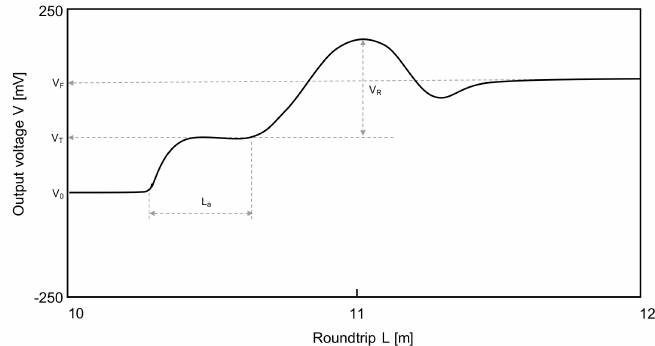
Figure 2. An example of the TDR waveform. V 0 , V T , and V F mean initial voltage, first reflected voltage, and converged voltage, respectively. V R denotes the di ff erent voltage with the first and second reflection. L a is the distance between the first and second reflected